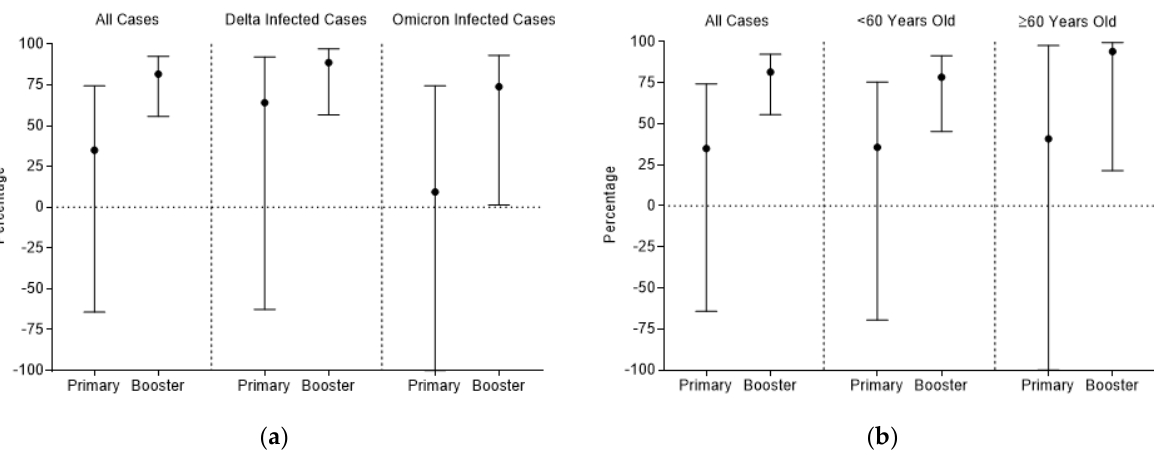
Figure 1. Protective effect of complete primary and booster of inactivated COVID-19 vaccines compared with the unvaccinated or partially vaccinated. ( a ) Protective effect against progression to pneumonia stratified by genotype; ( b ) protective effect against progression to pneumonia stratified by age.